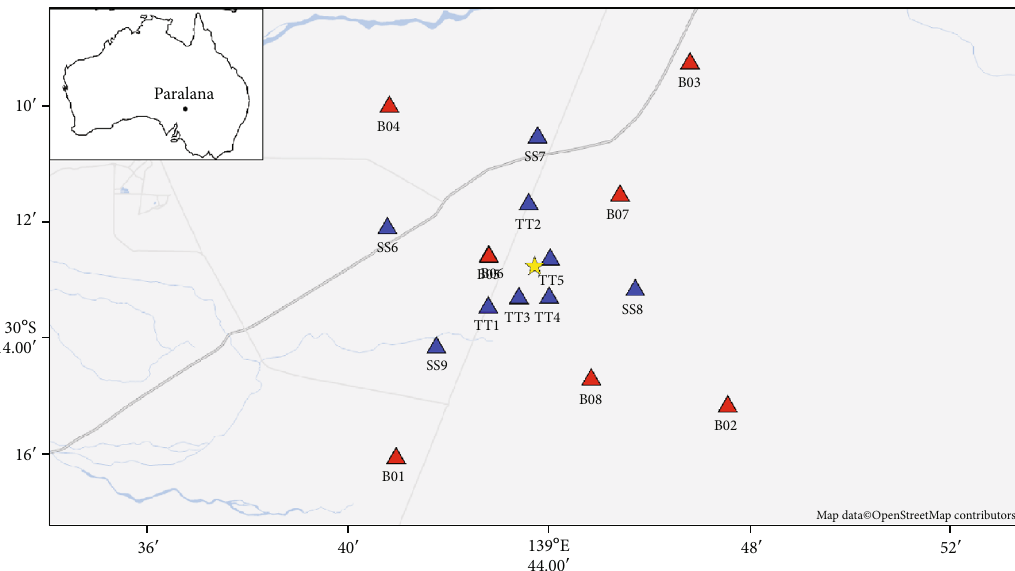
Figure 4: Paralana station network in map view. Wellhead position of injection well Paralana-2 is indicated by a yellow star. Blue triangles denote surface stations; red triangles denote instruments deployed in boreholes. The inset shows the location of the Paralana project site. Map data from OpenStreetMap (published under